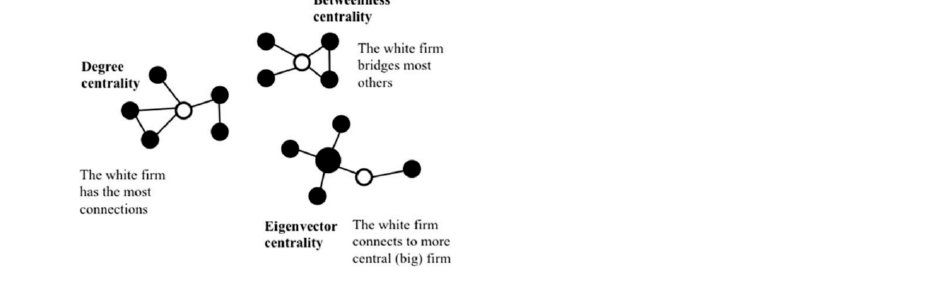
Figure 1. Three common forms of network centrality ( Reprinted with permission from Ref. [11]. 2017, John Wiley & Sons—Books ). John Wiley & Sons—Books).